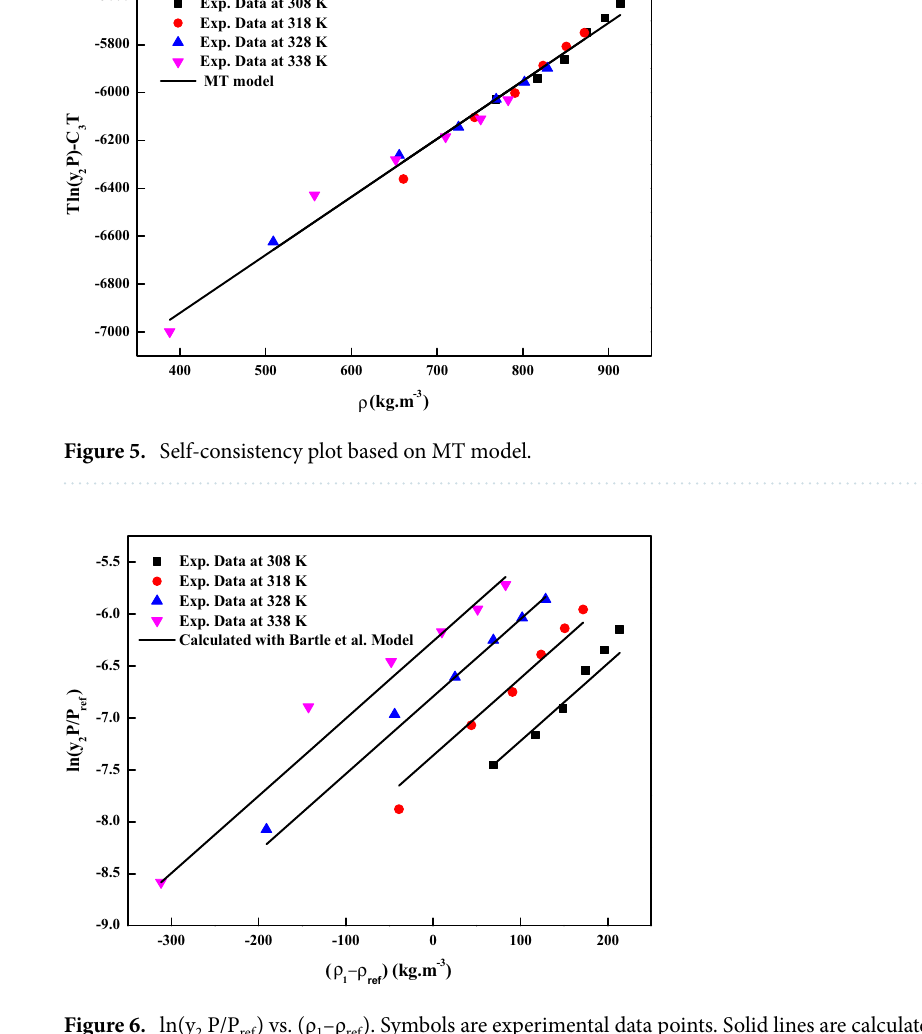
Figure 6. ln(y 2 P/P ref ) vs. (ρ 1 –ρ ref ). Symbols are experimental data points. Solid lines are calculated solubilities with Bartle et al., model.